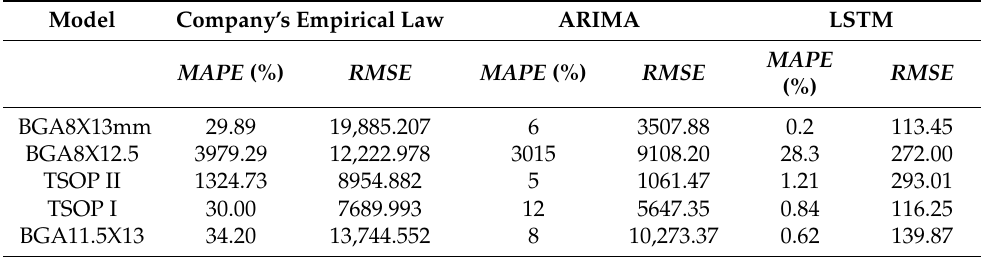
Table 1. Models’ evaluation indicators and